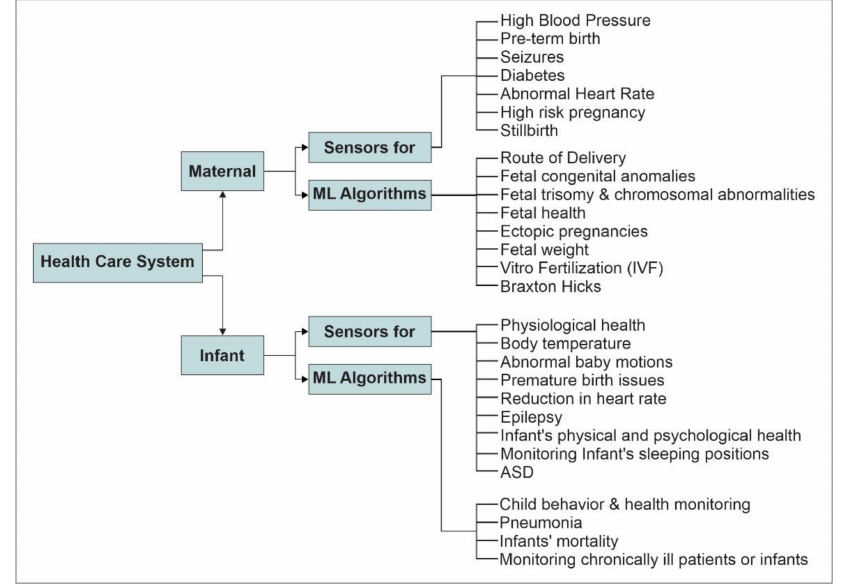
Figure 4. The structure of